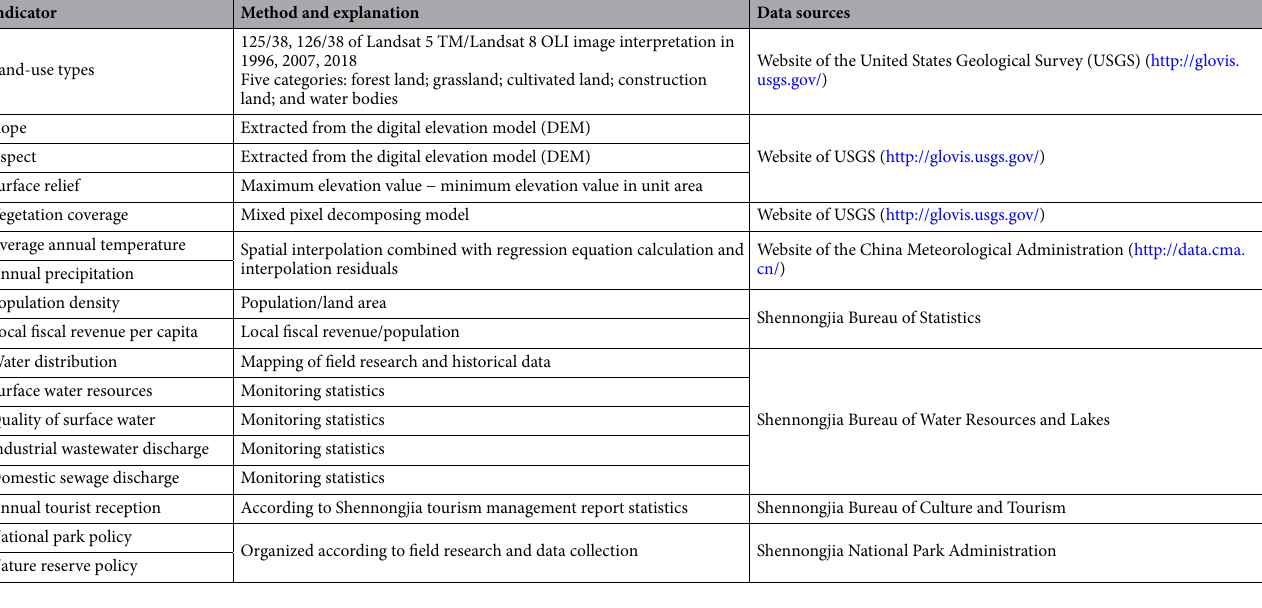
Table 1. Description and source of evaluation